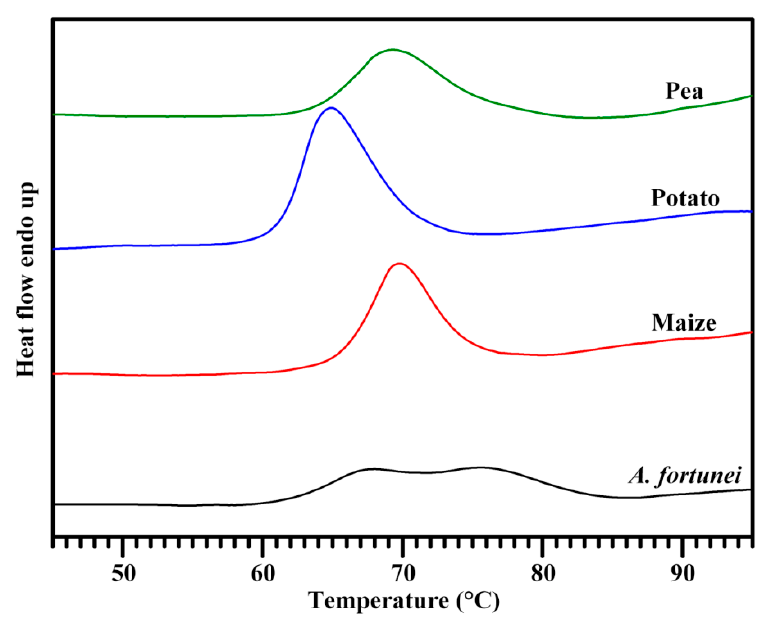
Figure 6. DSC thermogram of starch. Table 4. Thermal parameters of starch.